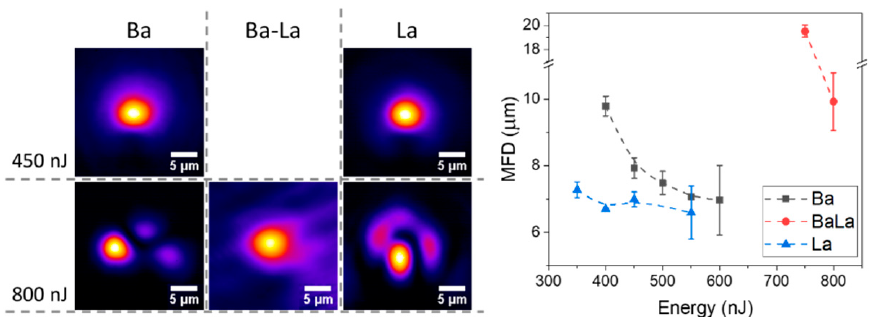
Figure 3. ( Left panel) Near field images and ( right plot) corresponding mode field diameters (MFD) at 1590 nm for the single-mode structures produced in the different glass compositions. The plot in Figure 3 shows the evolution of the MFD (for the single mode waveguides) as a function of the laser pulse energy. The plot indicates that the waveguide formation threshold is slightly smaller for the La-glass (350 nJ) while the MFD remains nearly constant (~7 µ m) for pulse energies up to ~550 nJ. At this energy, the transmission of the waveguides turns multimodal, generating a large uncertainty in the MFD estimation. For the Ba-glass, at its waveguide formation threshold (400 nJ), the MFD (~10 µ m) is substantially larger than for the La-glass and decreases with the pulse energy down to values close to 7 µ m. As for the La-glass, above a certain value (600 nJ), the structures behave as multimodal. The differences observed as a function of laser pulse energy in the behavior of the waveguides written in the Ba- and La-glasses are consistent with the expected differences in their thermal diffusivity and in the polarizabilities of the index carriers involved. The